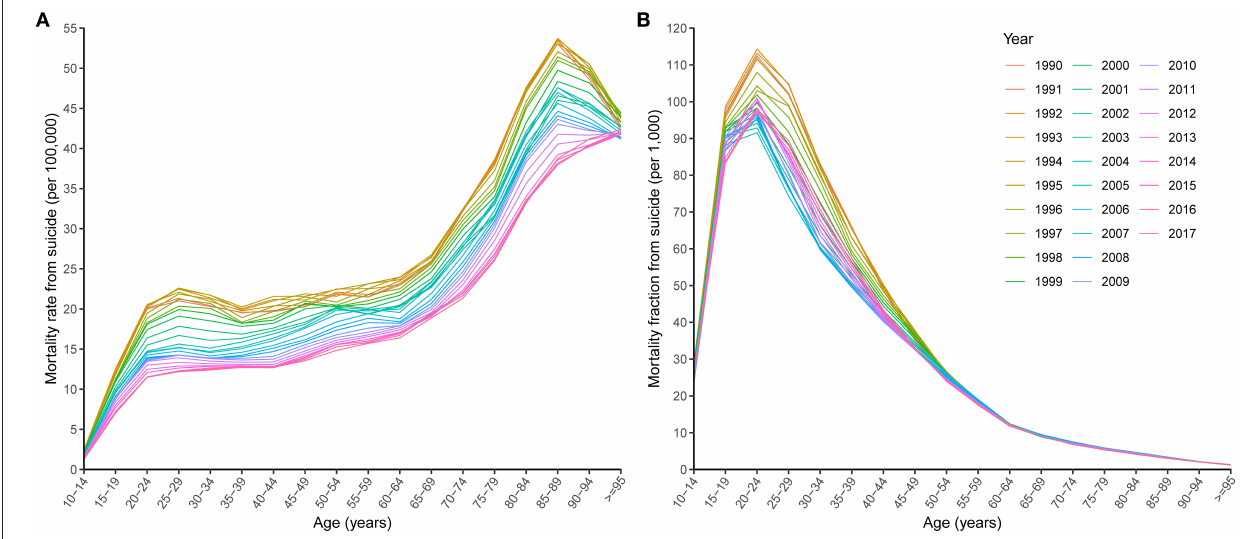
FIGURE 1 | Age-specific mortality rates (A) and mortality fractions (B) from suicide by year.